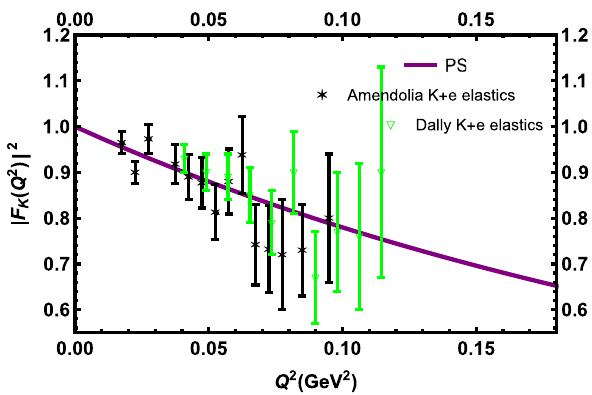
Fig. 8 Variation of | F K ( Q 2 | 2 at low Q 2 compared to existing experi- mental data [21,22] with | F K ( Q 2 = 0 ) | 2 normalized to one